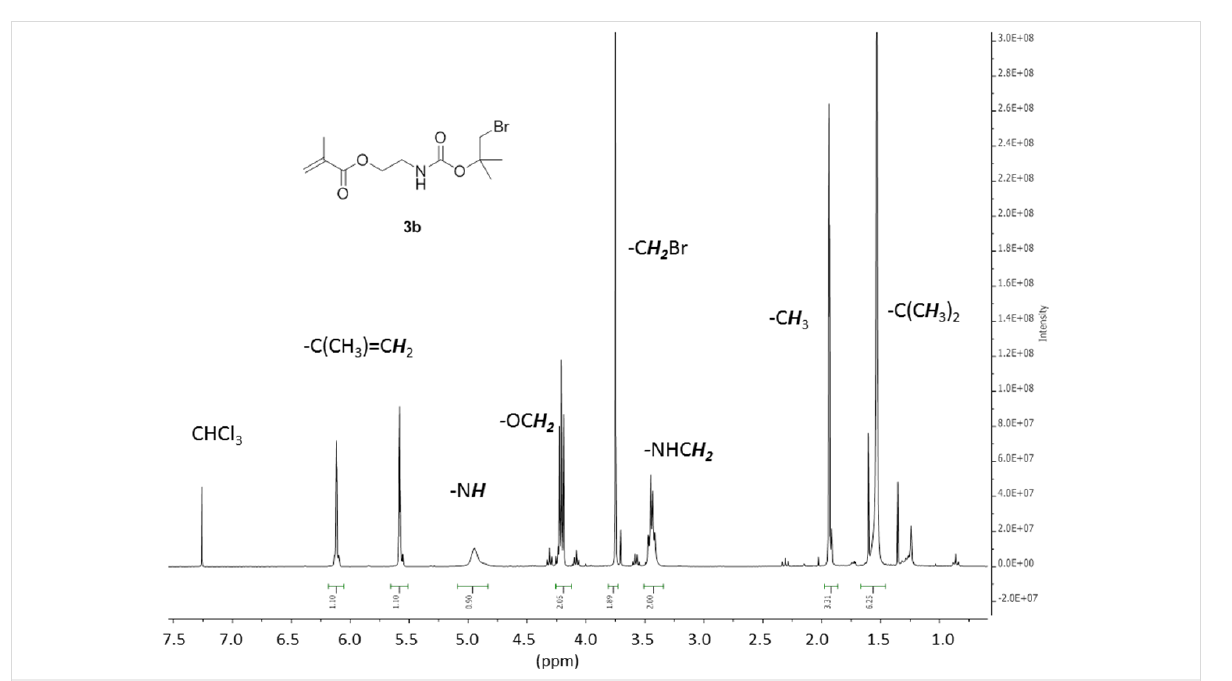
Figure 2: 300 MHz 1 H NMR spectrum of 3a in CDCl 3 .